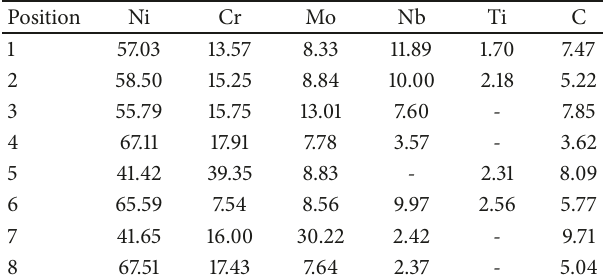
Table 3: Composition at some topical points, as obtained by EDS analysis